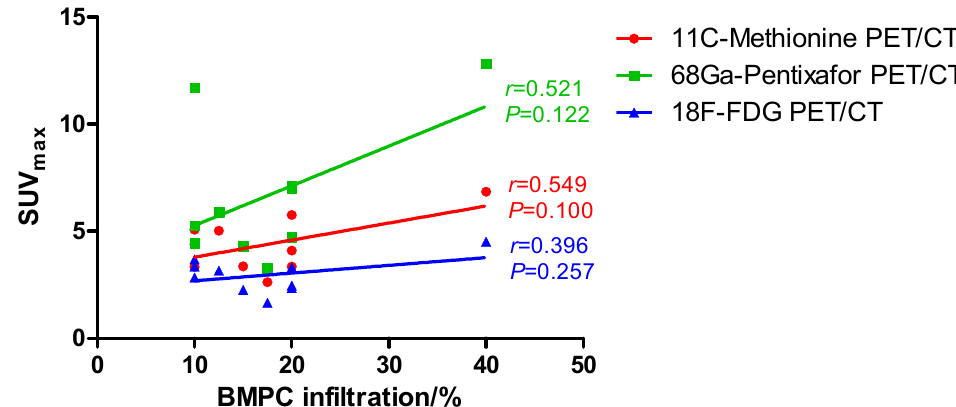
Figure 3. Correlation between bone marrow plasma cell (BMPC) infiltration and maximum standardized uptake value (SUV max ) of lumbar vertebrae (LV) L2-L4 on 11C-Methionine, 68Ga- Pentixafor, and 18F-FDG PET/CT: We did not find a significant correlation between BMPC infiltration and SUV max of LV L2-L4 on 11C-Methionine PET/CT (Pearson’s r = 0.549, p = 0.100, red), 68Ga- Pentixafor (Pearson’s r = 0.521, p = 0.122, green), and 18F-FDG PET/CT (Pearson’s r = 0.396, p = 0.257, blue).